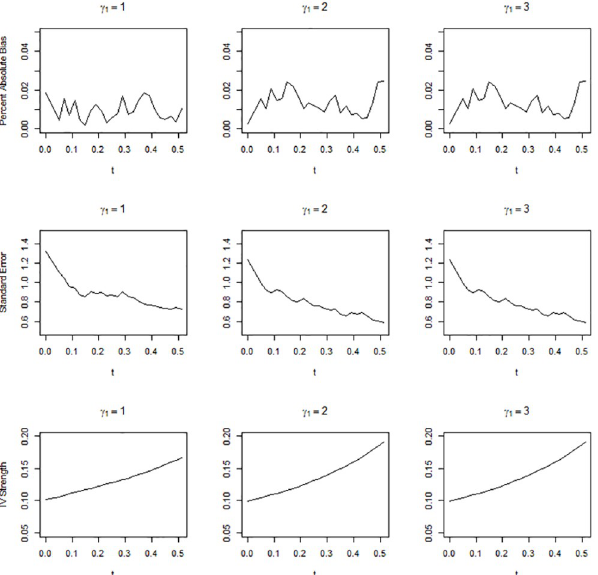
Fig 1. Absolute percentage bias, standard error, and IV strength for the local average treatment effect with a complier population size of 0.1. The X-axis indicates the percentile of the estimated compliance scores for the cutpoint t